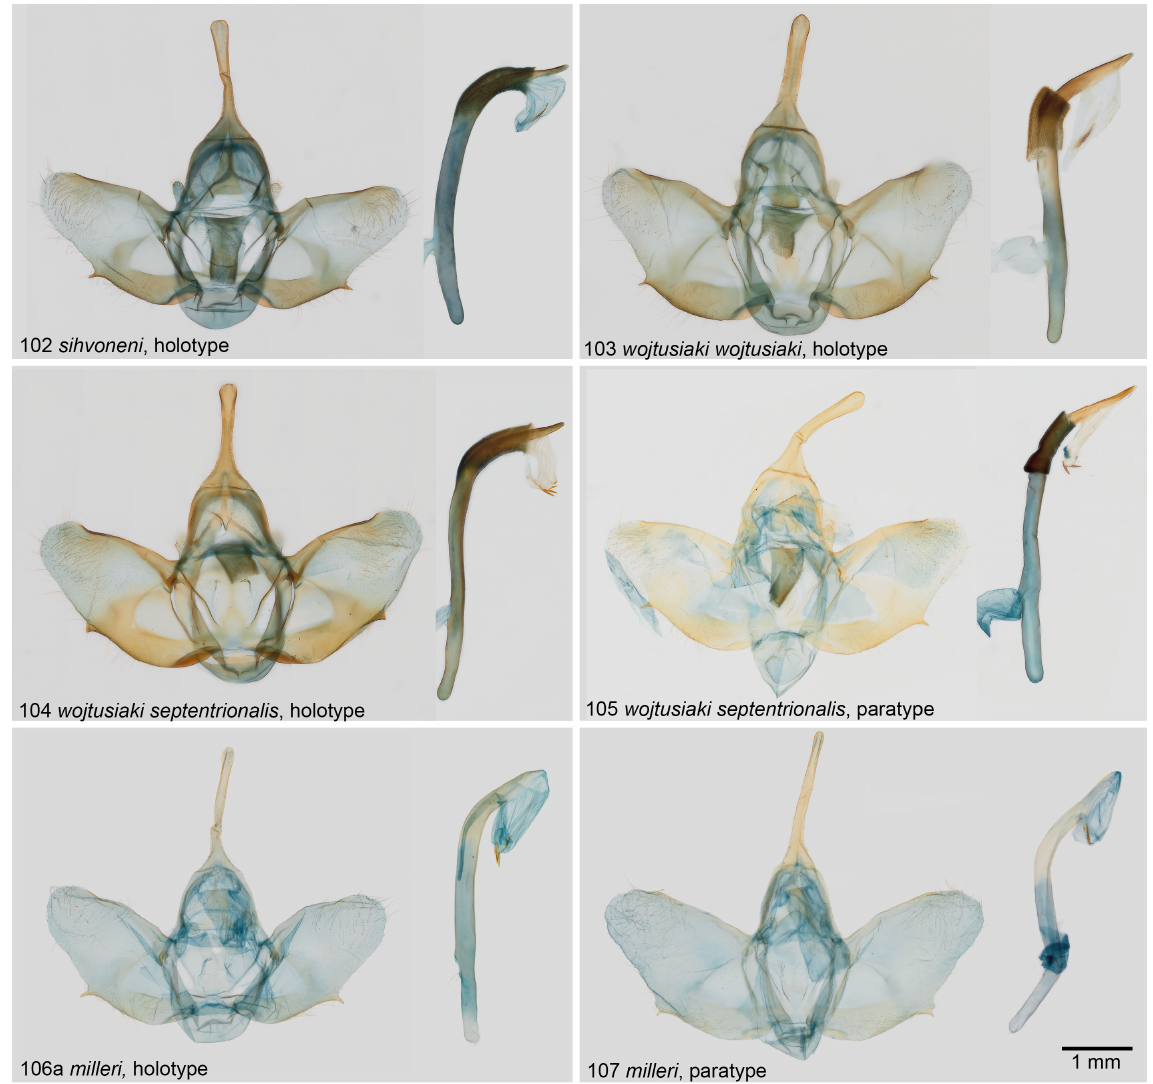
Figs 102–107. Male genitalia (left = valves; right = aedeagus). 102 . Callipia sihvoneni sp. nov., ♂, holotype (C-0418, COI data). 103 . C. wojtusiaki wojtusiaki sp. nov., ♂, holotype (C-0046, COI data). 104 . C. wojtusiaki septentrionalis subsp. nov., ♂, holotype (C-0012, COI data). 105 . C. wojtusiaki septentrionalis subsp. nov., ♂, paratype (C-0013, COI data). 106 . C. milleri sp. nov., ♂, holotype (C- 0370, COI data). 107 . C. milleri sp. nov., ♂, paratype (C-0008, COI